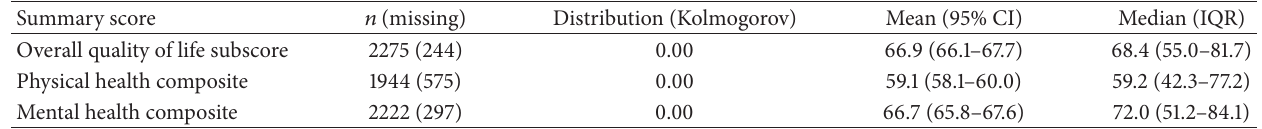
Table 7: MSQOL summary scores.